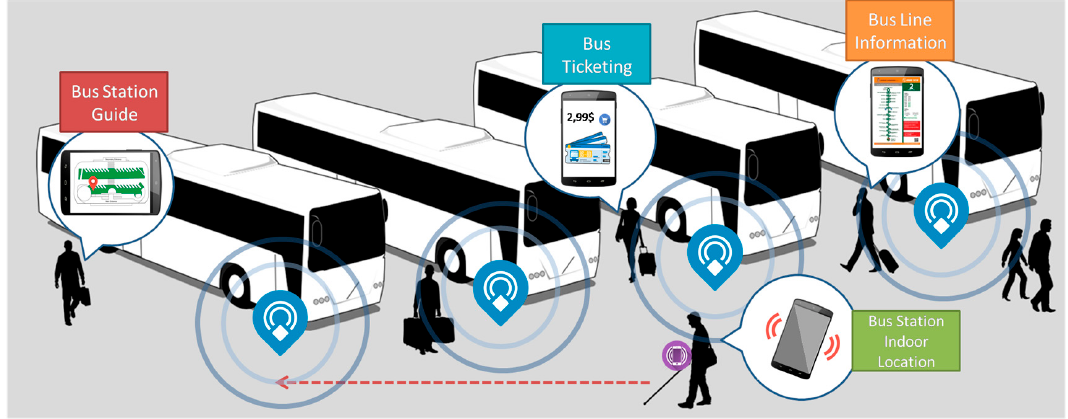
Figure 1. Schematic view of advanced information services that could be offered: bus station guide, ticketing, line information.